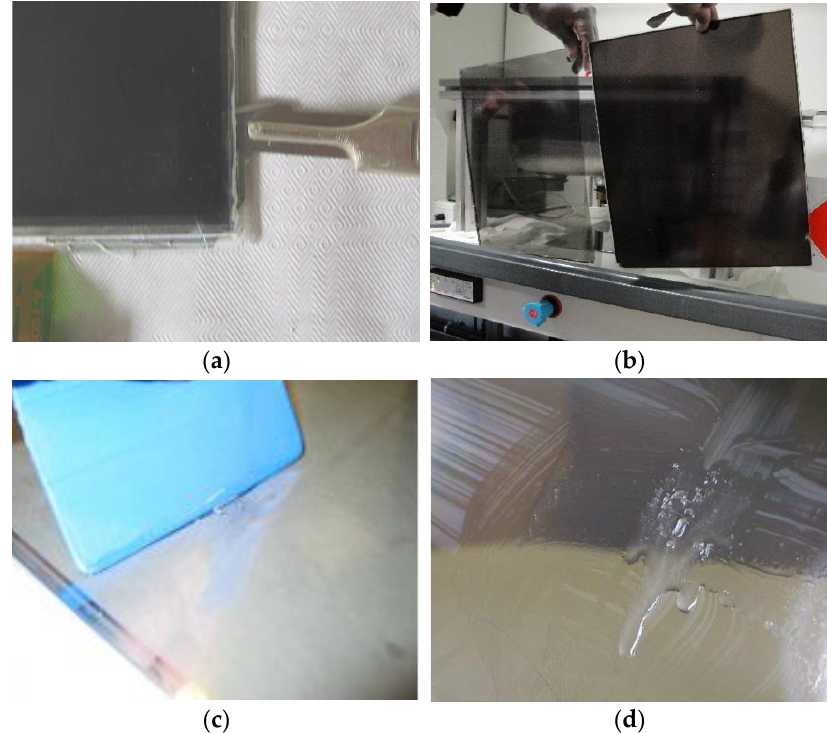
Figure 3. The opening stages of an LCD panel giving access to LCs. ( a , b ) Manual opening of the sandwiched glass plates using a scalpel. ( c ) Separation of the two glass plates, on the left-hand side, front of the panel consisting of color filters and black matrix; on the right-hand side, back side. ( d ) Collected LCs molecules with translucent and slightly viscous aspects.